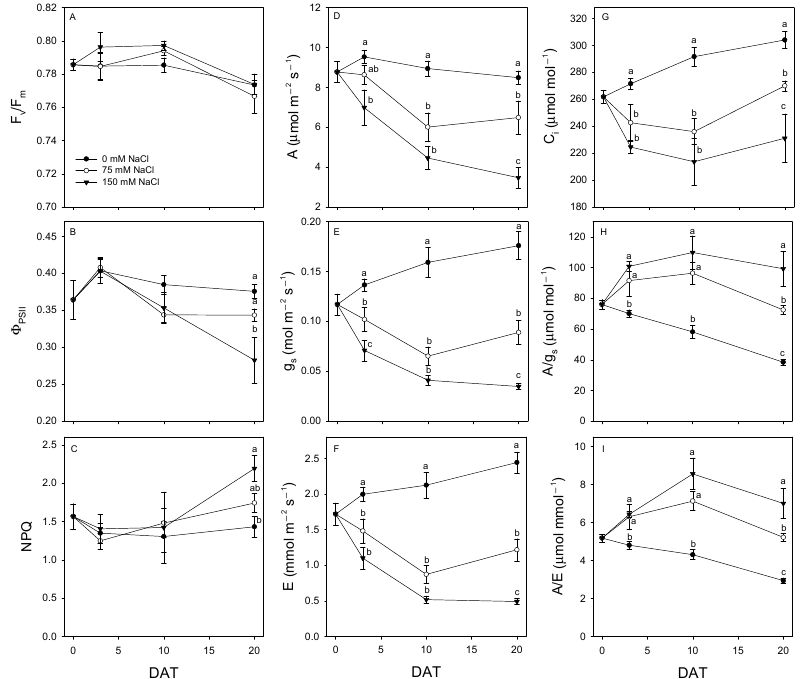
Figure 1. Variations of ( A ) potential e ffi ciency of photosystem II (PSII) photochemistry (F v / F m ), ( B ) actual photon yield of PSII photochemistry ( Φ PSII ), ( C ) non-photochemical quenching (NPQ), ( D ) CO 2 assimilation rate, ( E ) stomatal conductance (g s ), ( F ) transpiration rate, ( G ) intercellular CO 2 concentration (C i ), ( H ) intrinsic water-use e ffi ciency (A / g s ), and ( I ) instantaneous water-use e ffi ciency (A / E) at 0, 3, 10, and 20 days after treatment (DAT) with 0, 75, and 150 mM NaCl. Values are means ± SE ( n = 6–9). Di ff erent letters indicate significant di ff erences among treatments ( p ≤ 0.05, Fisher’s Least Significant Di ff erence,